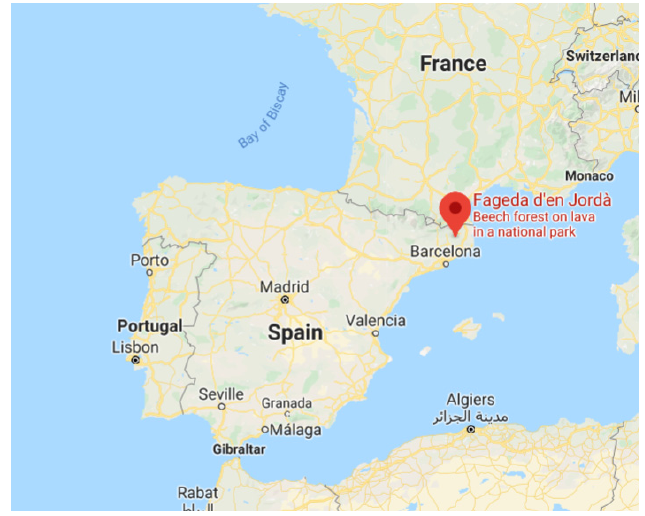
Figure 1. Location of the field experiment at Fageda d’en Jordà, in the North East of Spain.